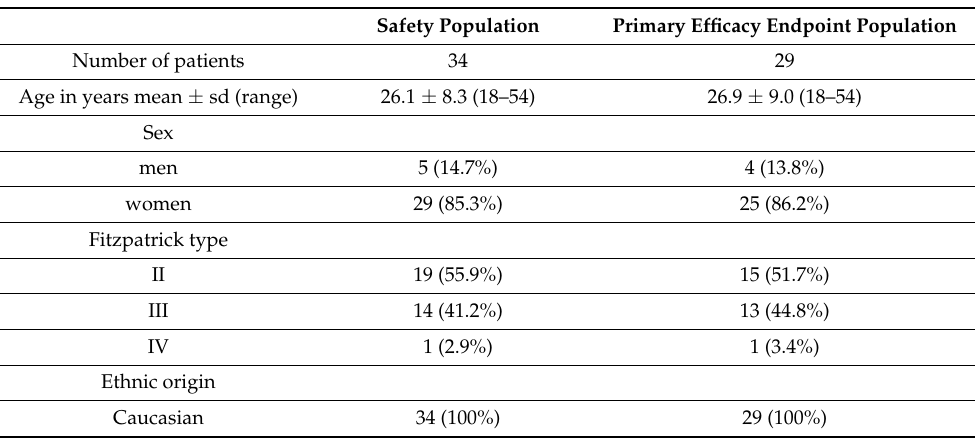
Table 2. Demographic data of